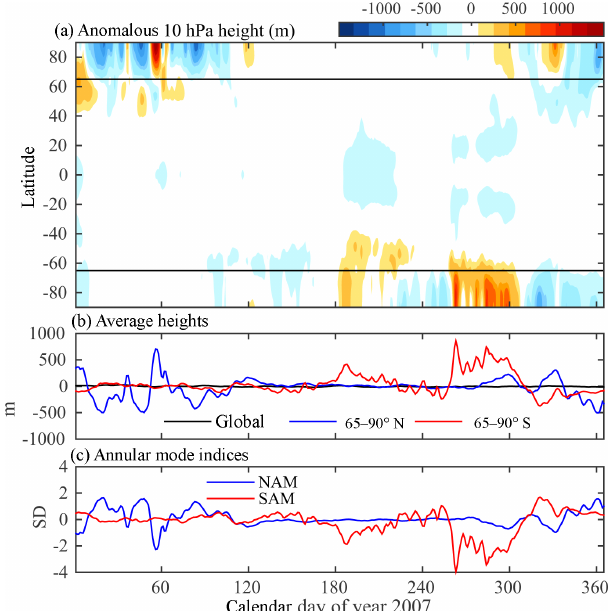
Figure 1. To illustrate our simplified method for calculating the an- nular mode indices, (a) shows anomalous zonal mean geopotential height, Z (cid:48) , at 10hPa for 1 year, 2007. As detailed in the text, anoma- lies are defined relative to a smoothed annual cycle. Panel (b) shows global and polar cap averages of Z (cid:48) for this period, and (c) the Northern and Southern Annular Mode indices at this level, defined as − 1 × the respective polar cap averages less the global mean, and then normalized to have unit variance. The choice of year 2007 was arbitrary, but did exhibit a sudden stratospheric warming on 24 February, which is associated with high geopotential height over the polar cap and low NAM index around day